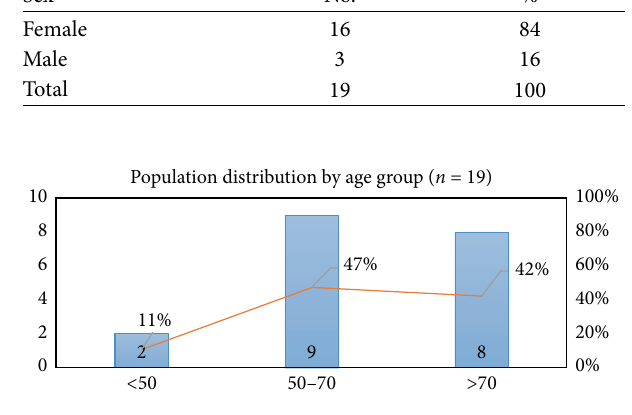
Figure 2: Population distribution by age group.